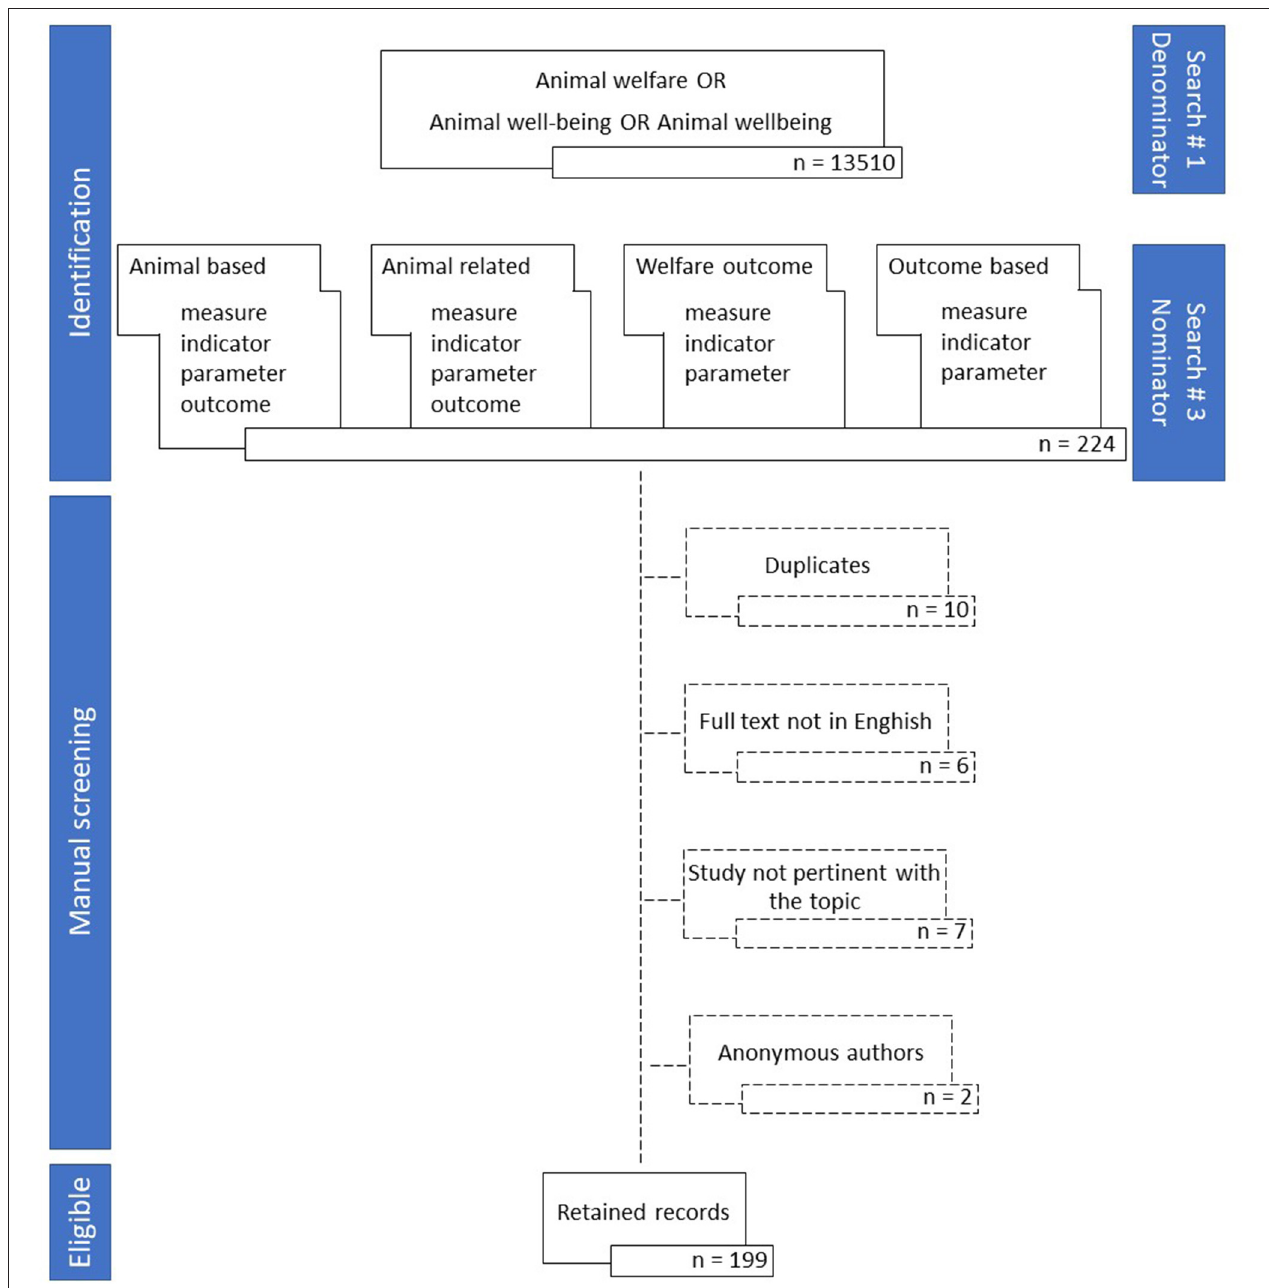
FIGURE 1 | Flow chart graphically representing the search protocol. The dashed line represents the papers excluded at manual screening.